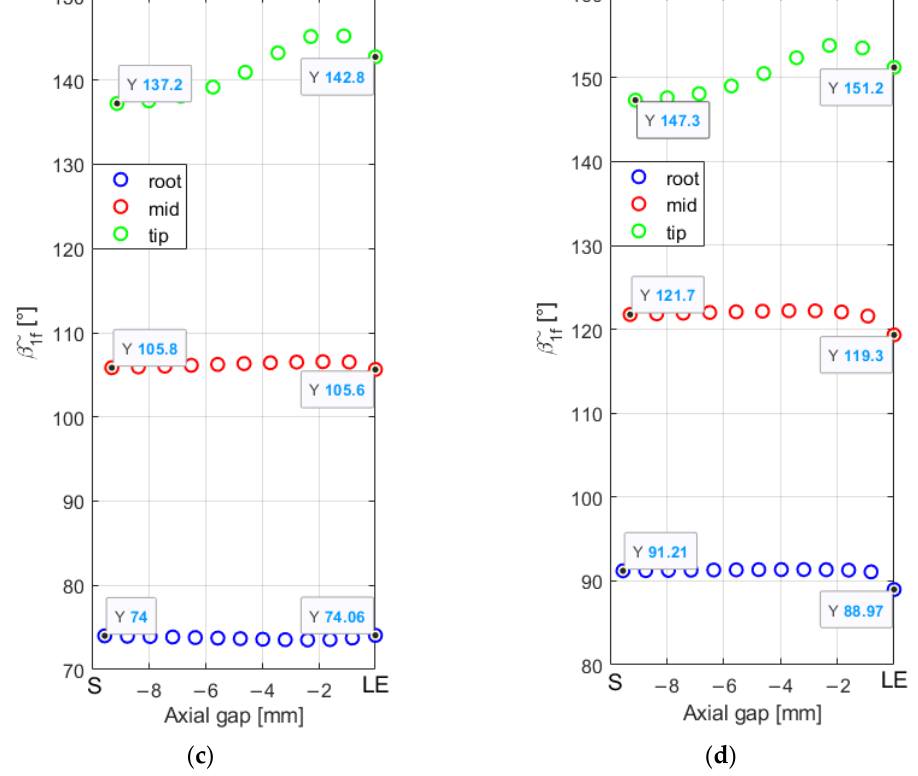
Figure 12. Mass-averaged relative velocity angles to the bucket in the axial gap: ( a ) v1; ( b ) v2; ( c ) v3; and ( d ) v4.